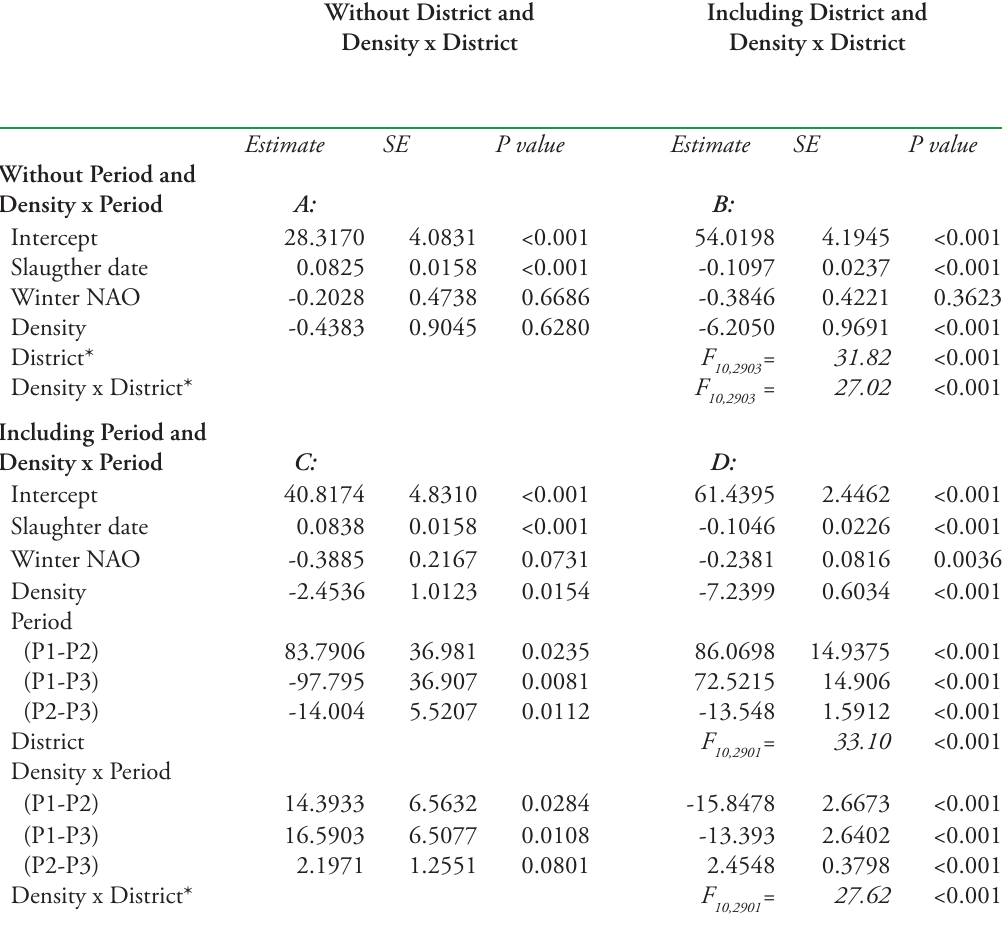
Table 4. Parameter estimates with standard errors (SE) and P -values for the mixed linear models fitting the autumn carcass masses (in kg) of male yearlings at the medium density scale (i.e. island ) without district and period and theirs interactions with density ( A: ), including district within the sub-region and density by district interaction ( B: ) (for the main effect and the interaction the ANOVA results are presented in italic), with period (P1: 1983-86, P2: 1996-2001; P3: 2002-2004) and density by period interaction ( C: ), and including district and period and theirs interactions with density ( D: ). Slaughter date and winter NAO are entered as covariates in the